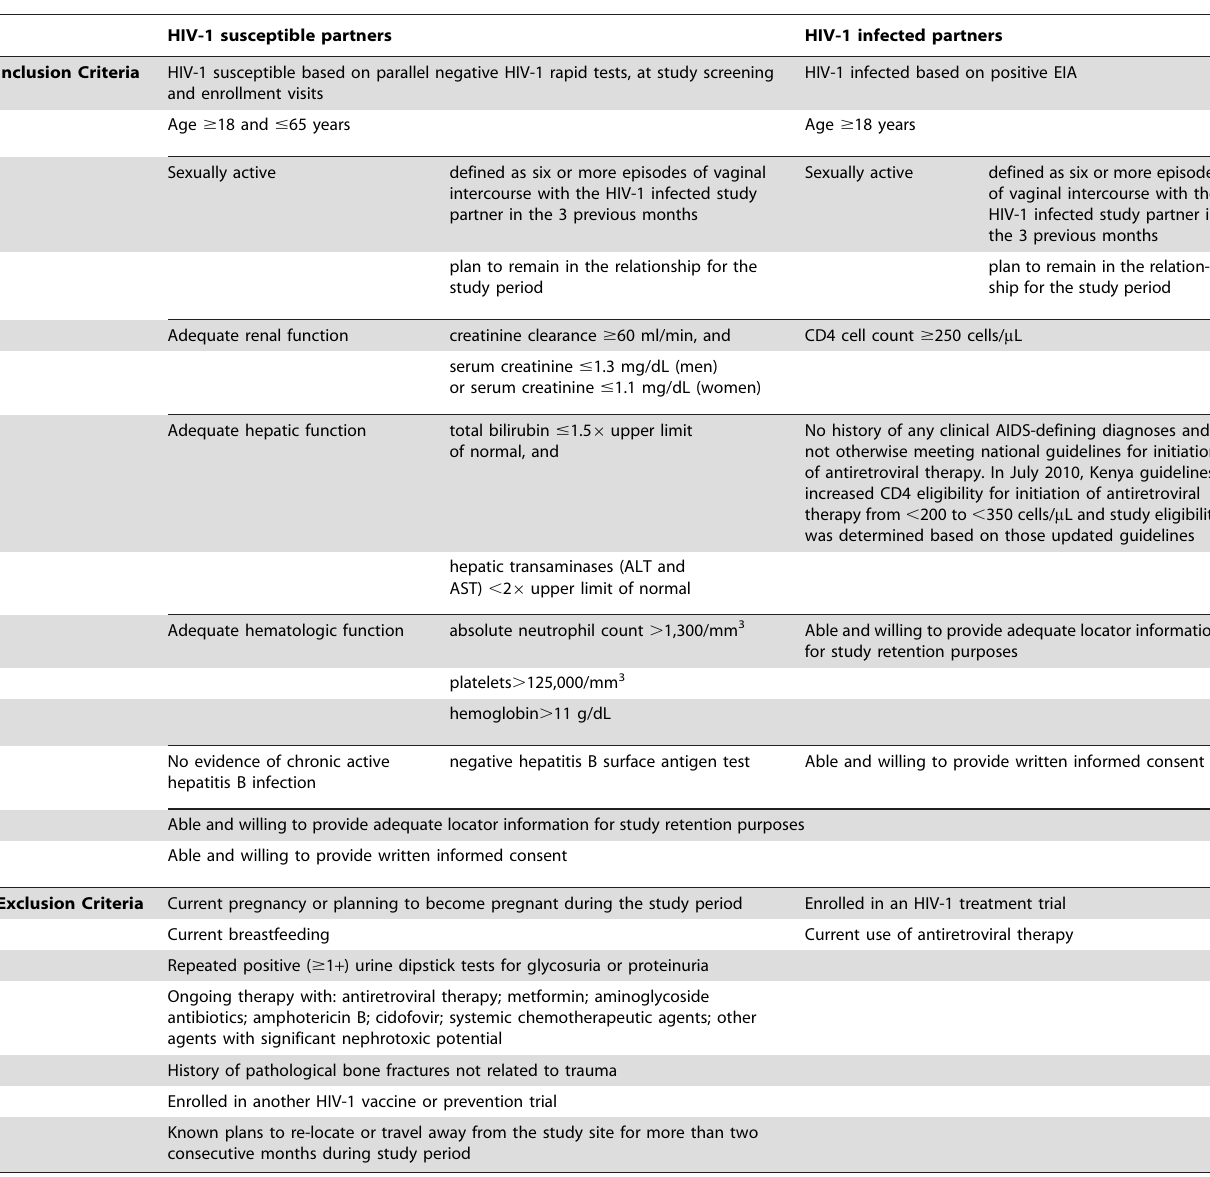
Table 1. Study Inclusion and Exclusion